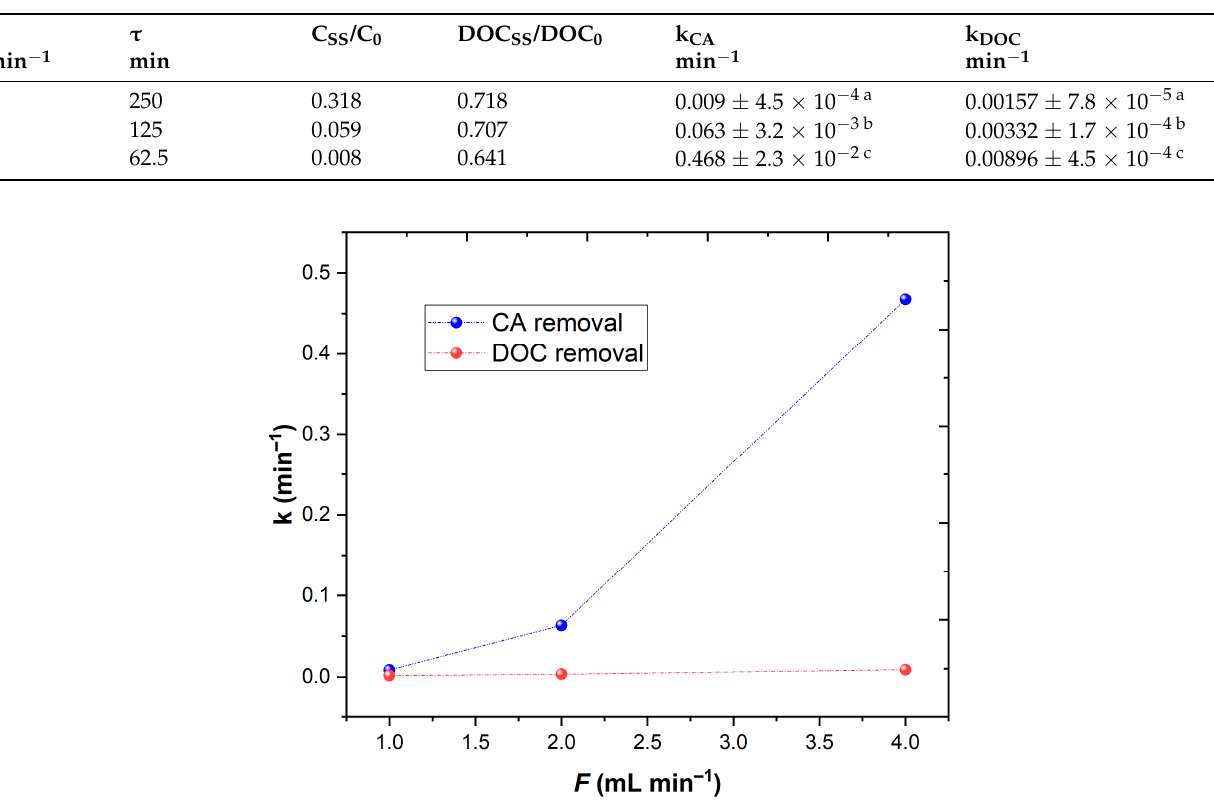
Figure 9. Dependence of the kinetic constant (k) to the flow rate ( F ) of the continuous mode reactor.